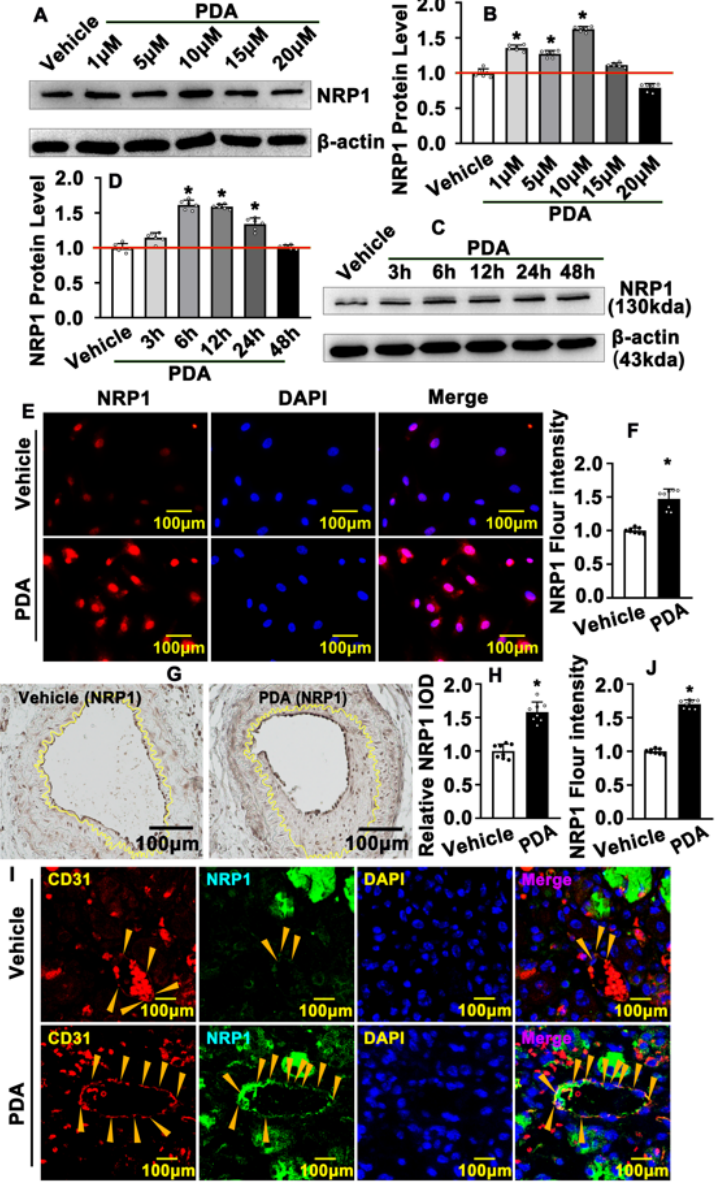
Figure 4. PDA induces vascular endothelial cell NRP1 expression after vascular injury. ( A ) Western blotting was performed to determine the expression of NRP1 in HUVEC-Cs after PDA (10 μ M, 24 h) treatment with different doses, and the quantification data are shown in ( B ) ( n = 8). ( C ) Western blotting was performed to determine the expression of NRP1 in HUVEC-Cs after PDA (10 μ M) treatment at different time points, and the quantification data are evaluated in ( D ) ( n = 8). ( E ) IF